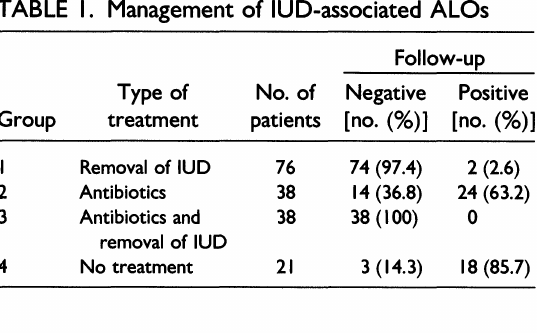
TABLE I. Management of IUD-associated